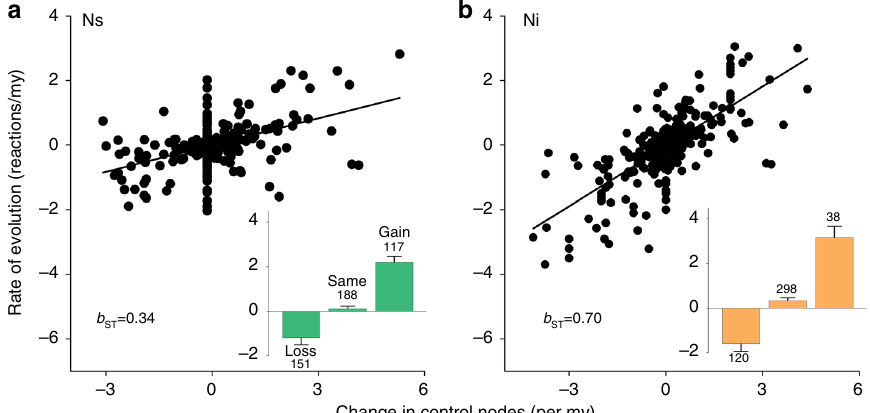
Fig. 5 Internalization of control over external inputs enables accelerated occupancy of enzymatic network and faster diversi fi cation of carotenoid pathways. Relative contribution of a change in a number of source controls, Ns, and b number of internal controls, Ni, in extant and ancestral networks to the rate of evolution (reactions/my) of carotenoid pathways. P < 0.05 for both standardized regression coef fi cients ( b ST ). Insets show mean ± s.e.m. evolutionary rates (nodes/my) for loss, retention, and gain of control nodes,